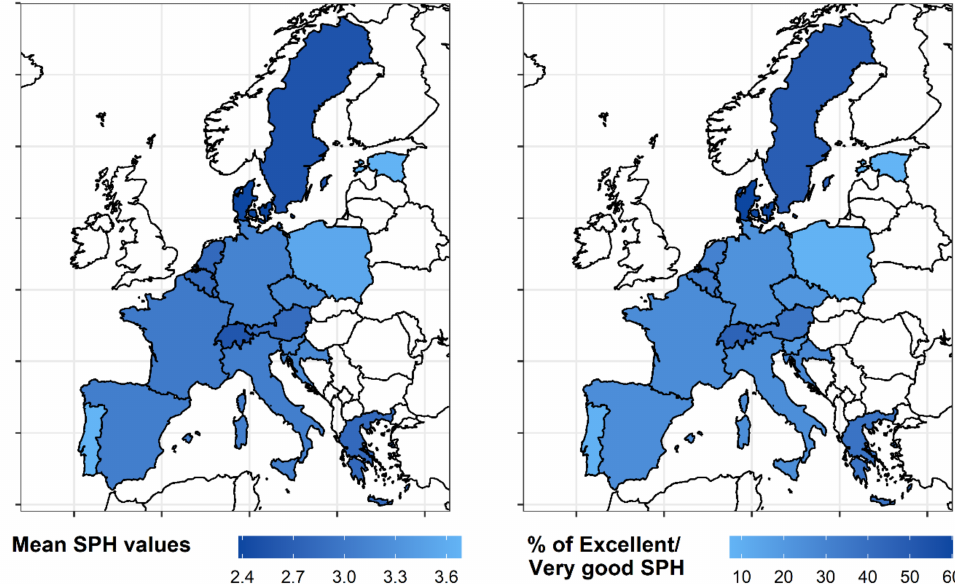
Figure 1. Mean Self-Perceived Health (SPH) values and prevalence of a health status rated as excellent or very good based on the country of domicile.